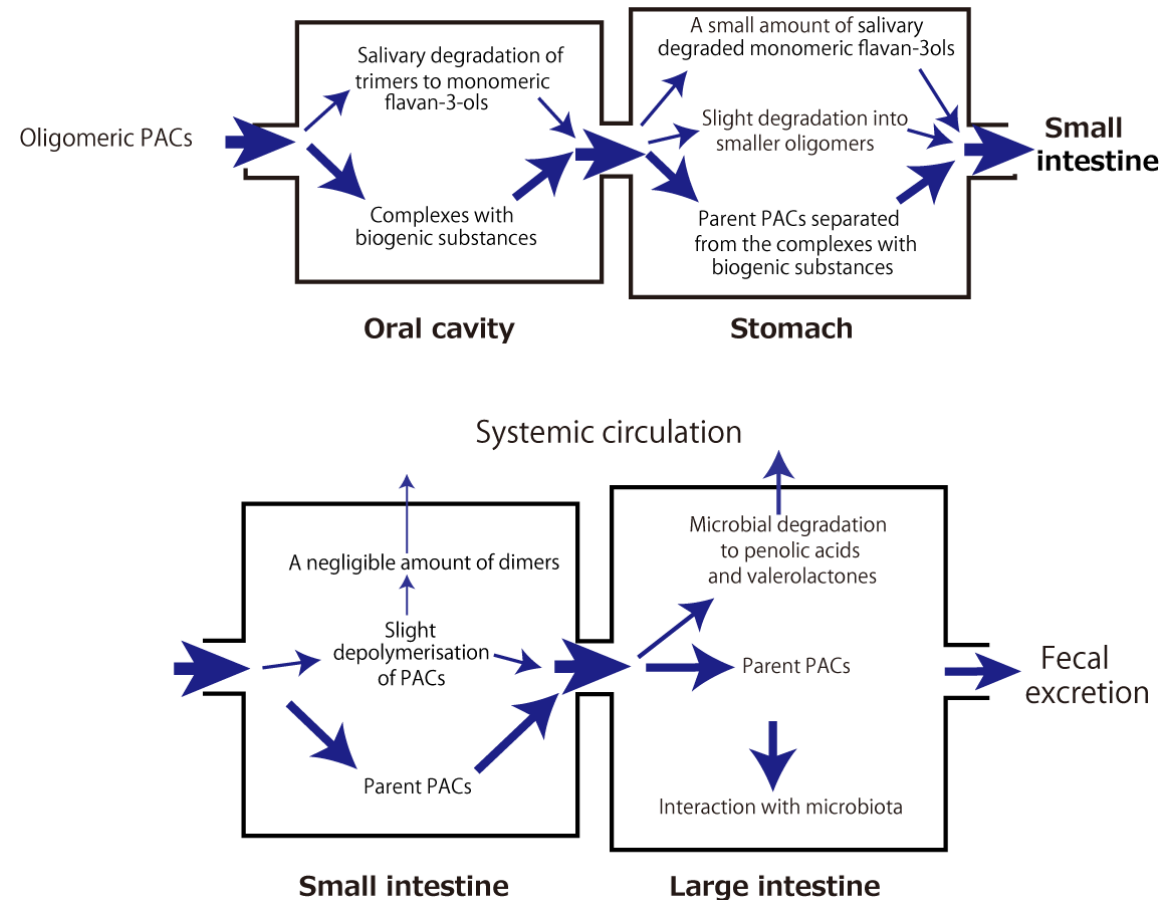
Figure 2. Intradigestive fate of orally ingested proanthocyanidins (PACs).